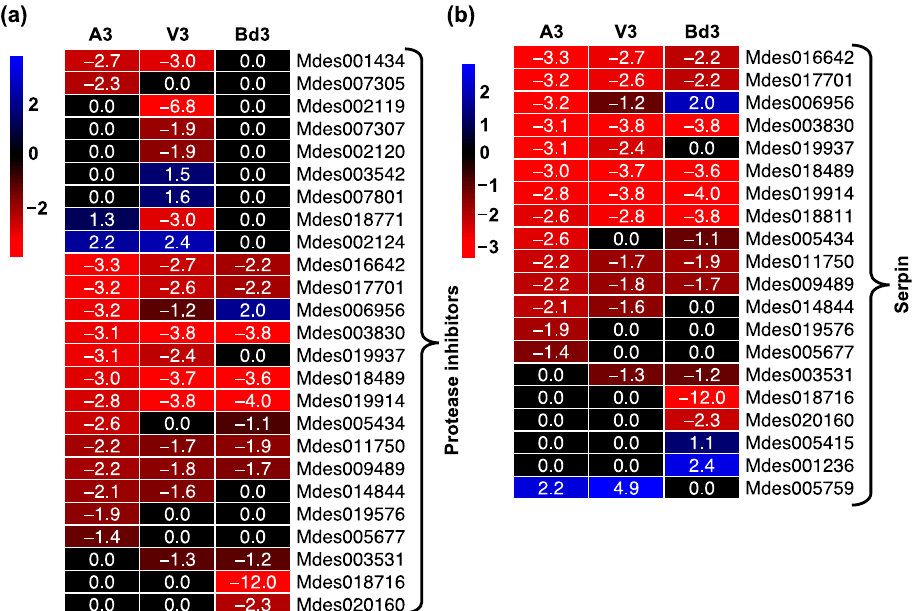
Figure 8. Differential expression of protease inhibitors in Hessian fly larvae 3 days after hatch (DAH). Heatmaps depict expression profiles of genes encoding protease inhibitors in avirulent (A3), virulent (V3), and Bd3 larval transcriptomes. ( a ) Differentially expressed genes encoding protease inhibitors. ( b ) Expression of genes encoding serpins, a protease inhibitor specifically targeting serine proteases. Log2 fold-change RNA-Seq values are shown within each cell of the heatmap. Blue represents up-regulated genes, and red represents the down-regulated genes, while genes not differentially expressed at a particular time-point are indicated in black.